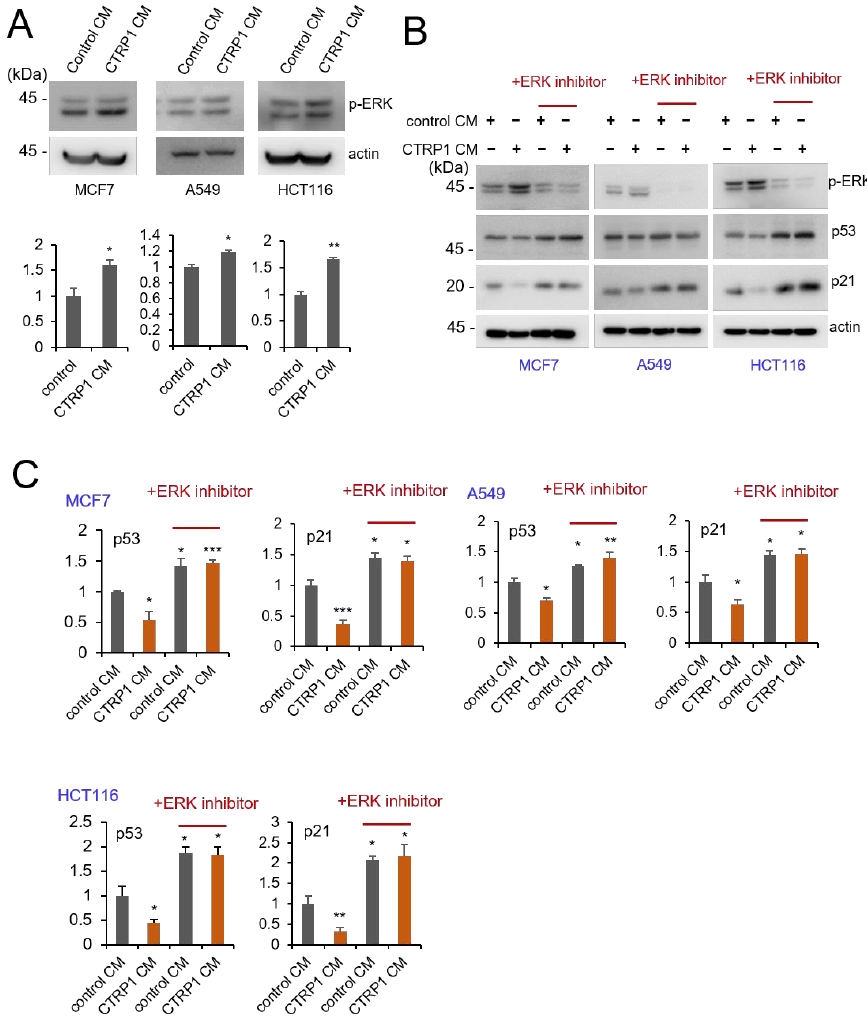
Figure 7. CTRP1 induces cell proliferation by activating the ERK signaling pathway. ( A ) CTRP1 CM increases p-ERK levels by activating the ERK signaling pathway. Control CM- and CTRP1 CM- treated HCT116 cells, MCF cells, and A549 cells were incubated with either control or ERK inhibitor. The level of p-ERK protein was quantified with an anti-p-ERK antibody and depicted in the graph (* p < 0.05, ** p < 0.01). Images of the uncropped western blots can be found in Figure S6. ( B ) ERK inhibitor treatment rescues p53 and p21 levels via inhibition of the ERK pathway. Cells were treated with either control or ERK inhibitor (FR180204, 10 μM) for 24 h. After treatment, cells were harvested and probed with the indicated antibodies. Images of the uncropped western blots can be found in Figure S7. ( C ) The level of p53 and p21 protein was quantified and depicted in the graph (* p < 0.05, ** p < 0.01, *** p < 0.005).